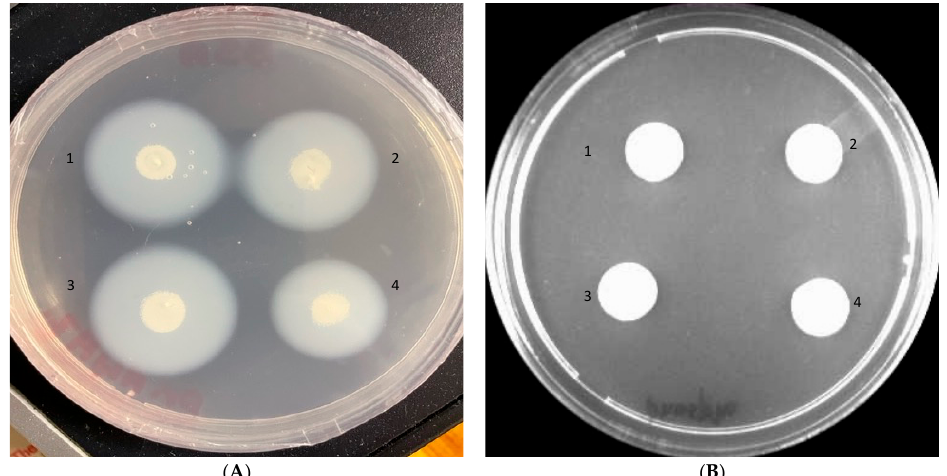
Figure 3. Proteinase ( A ) and phospholipase ( B ) activities of different C. glabrata isolates on BSA and egg yolk plates, respectively. A zone of clearance around the colonies ( A ) indicates positive proteinase activity, while no precipitation zones around the colonies ( B ) indicates negative phospholipase activity. (1) C. glabrata ATCC2950; (2) C. glabrata 3411; (3) C. glabrata 3469; and (4) C. glabrata